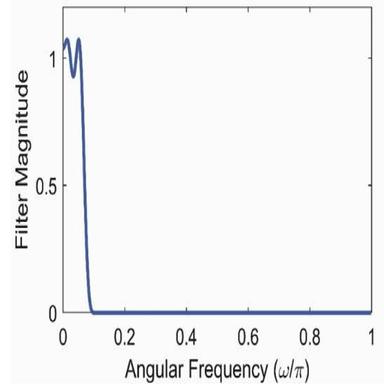
Magnitude of the low-pass FIR filter used to process input thermal contrasts.